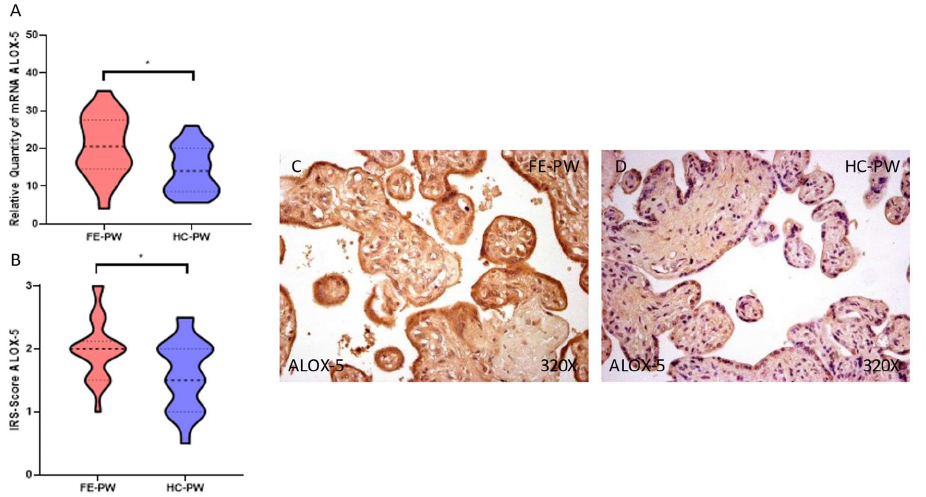
Figure 3. ( A ) ACSL-4 mRNA expression in both the FE-PW (first episode of psychosis in pregnancy) and HC-PW groups (healthy controls). ( B ) IRS-Scores for ACSL-4 expression in the placenta villi of the FE-PW group and the HC group. ( C , D ) Images showing the immunostaining for ACSL-4 in the placenta villi of the FE-PW group and the HC-PW group. p < 0.01 (**). Simultaneously, the gene expression of ALOX-5 was also significantly higher in FE-PW (FE-PW = 20.678 ± 8.046 RQ versus HC-PW = 14.293 ± 6.157 RQ; * p = 0.0111 Figure 4A). Regarding protein expression, we report a significant increase in ALOX-5 in the FE-PW group (FE-PW = 2.000 ± 0.488; HC-PW = 1.600 ± 0.553, * p = 0.0293, Figure 4B). When observed with a microscope, the augmented ALOX-5 expression was found in the different parts of the villi, including syncytiotrophoblasts, cytotrophoblasts, the matrix, and fetal capillaries (Figure 4C).